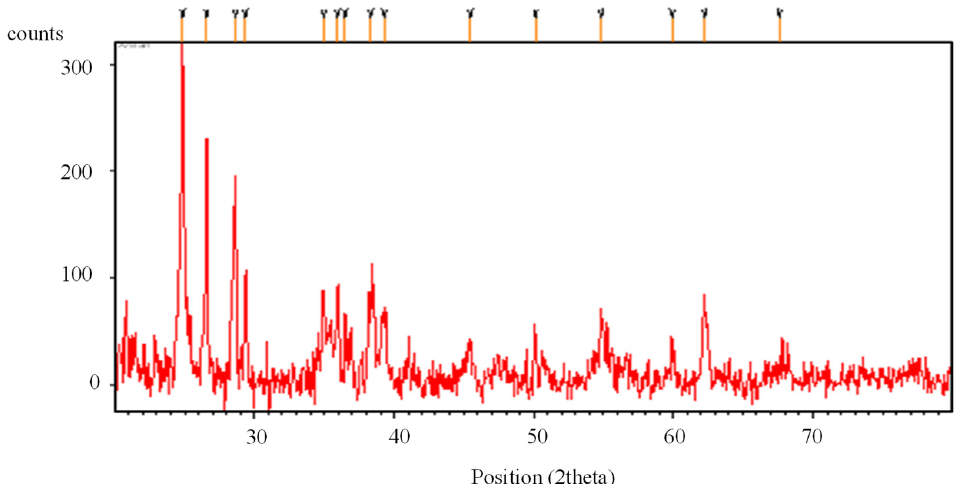
Figure 3. XRD pattern of MK sample.